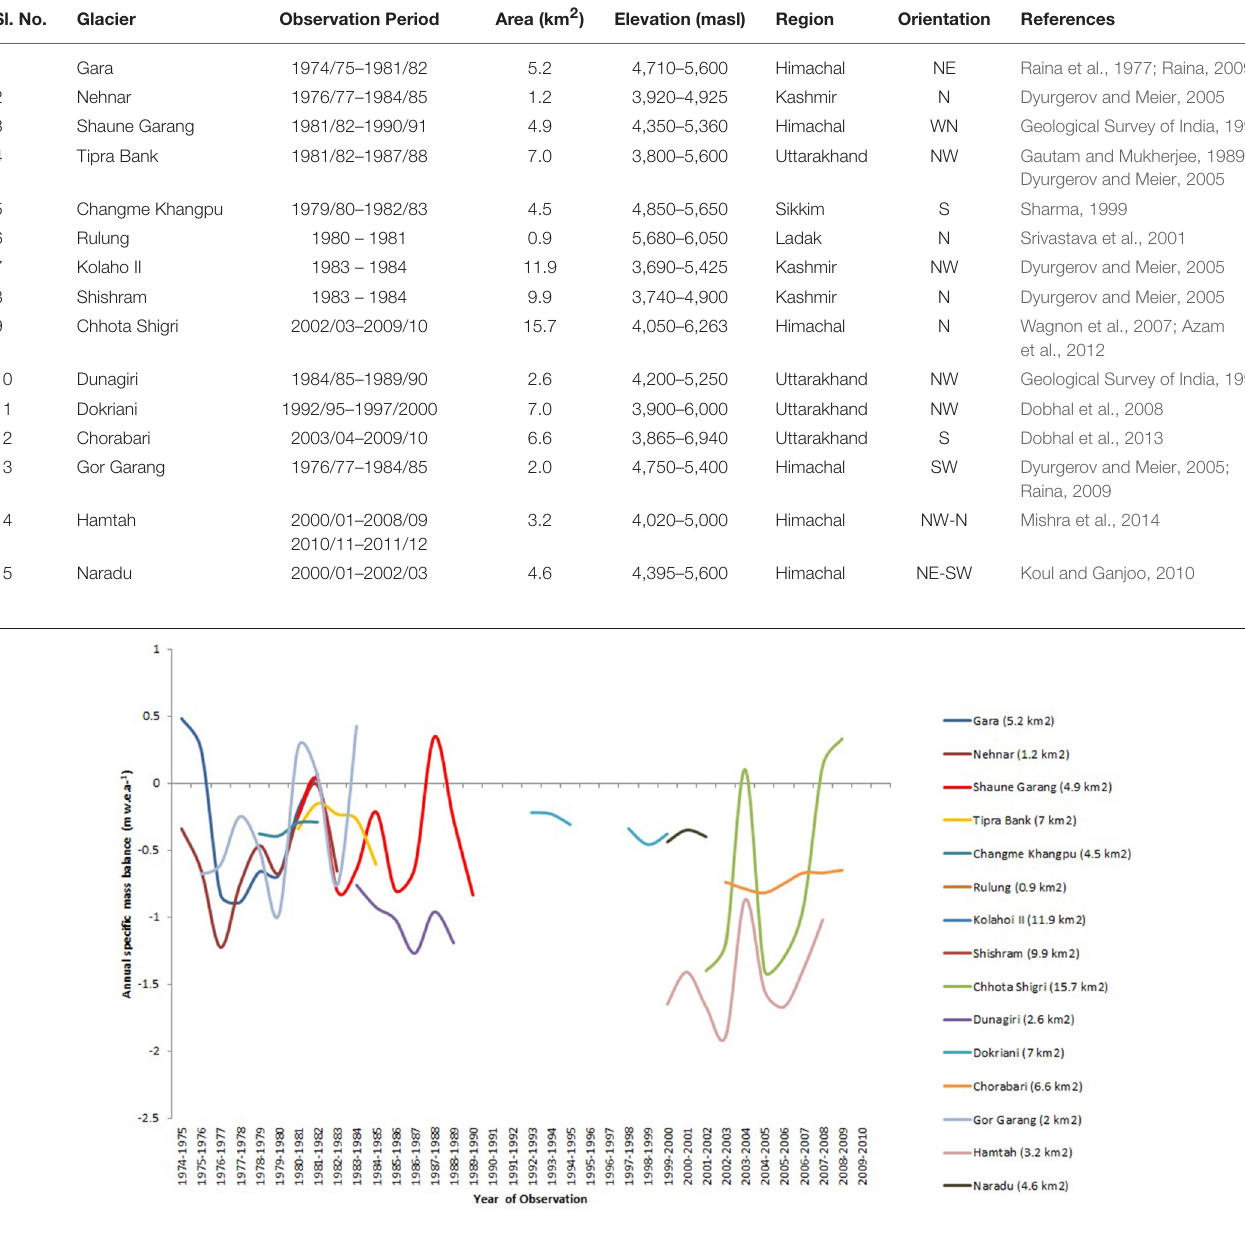
TABLE 2 | Topographic details of the glaciers of IHR having the mass balance observation through glaciological method. Sl. No.